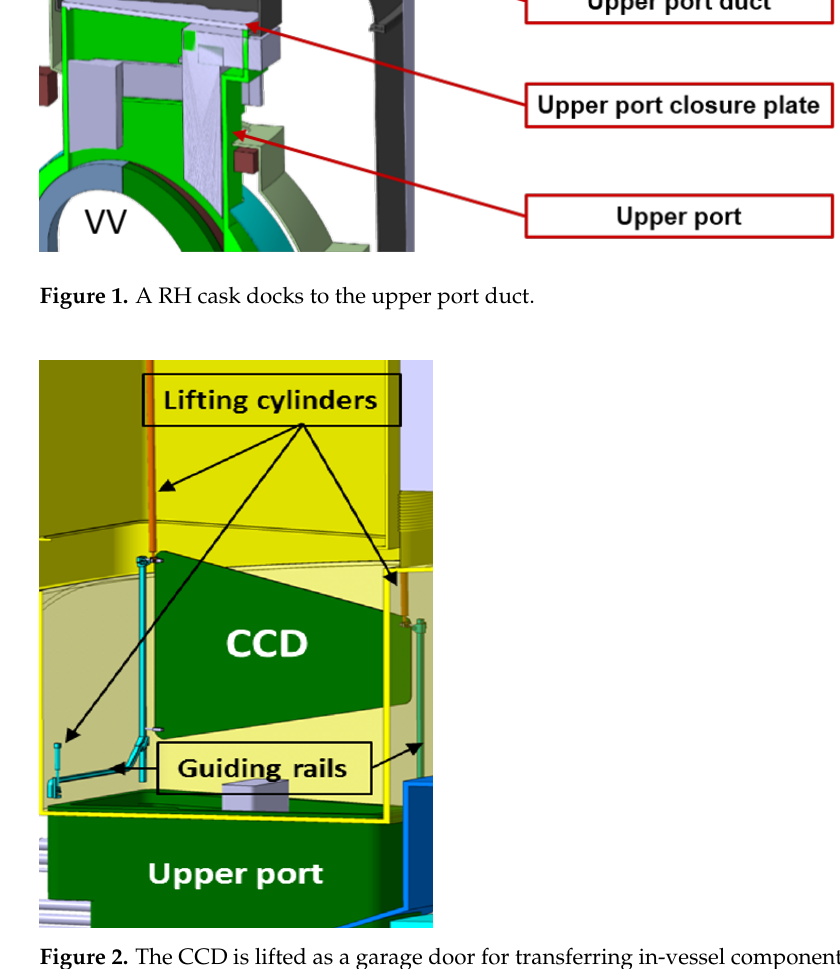
Figure 2. The CCD is lifted as a garage door for transferring in-vessel